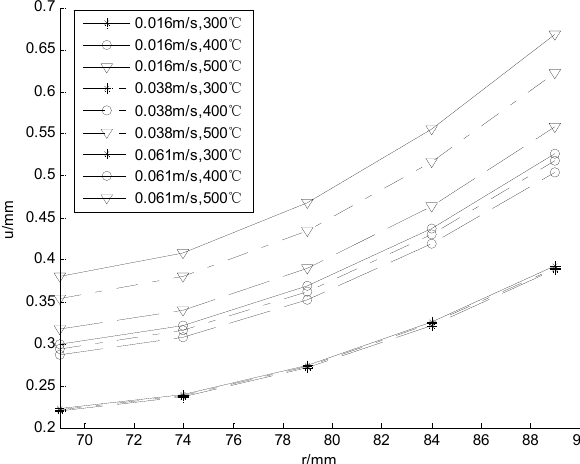
Figure 7. Sectional radial deformation of point B.